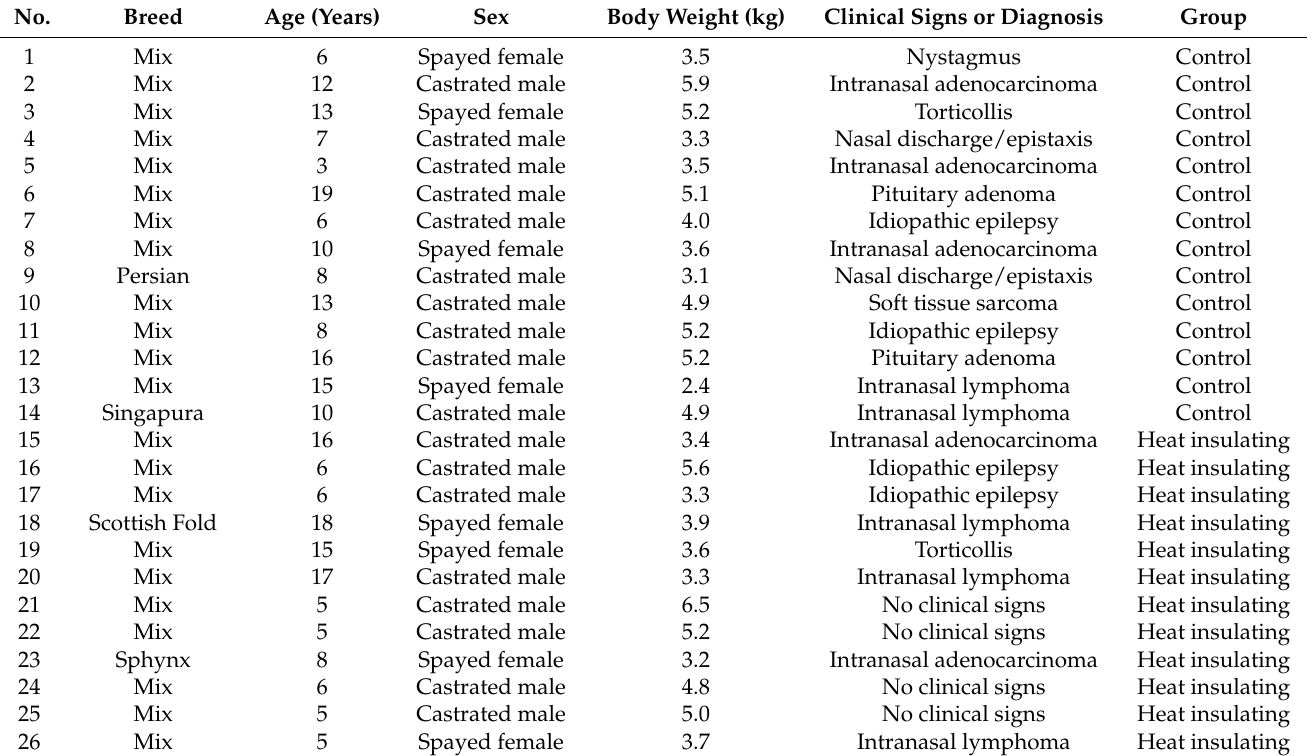
Table 2. Profiles of 26 cats used in examination in this study.